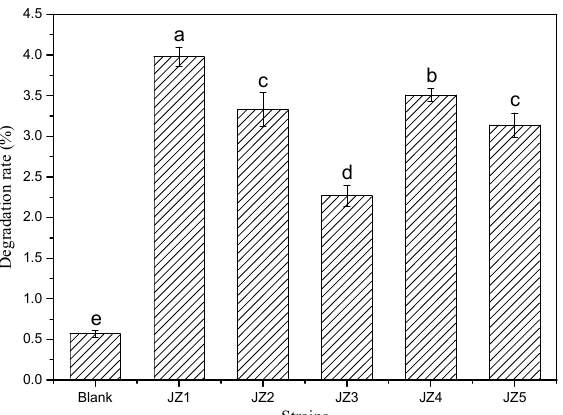
Figure 1. Degradation rate of PBAT film by strains in basic salt + 1% tryptone medium; a-e are symbols indicating the significance of the difference.